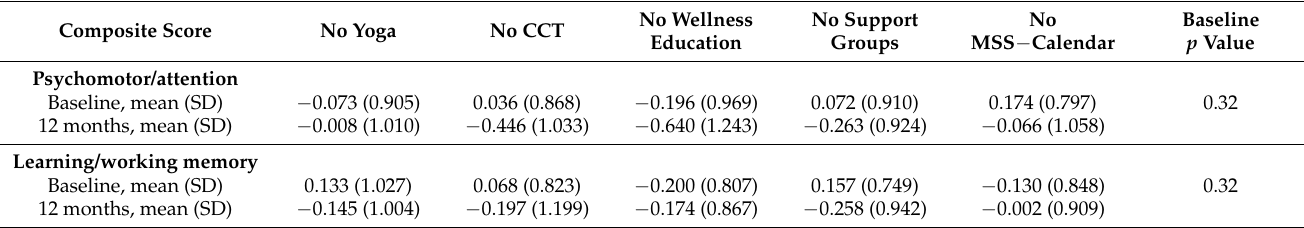
Table 2. Patient Cogstate composite scores at baseline and 12 months follow-up.